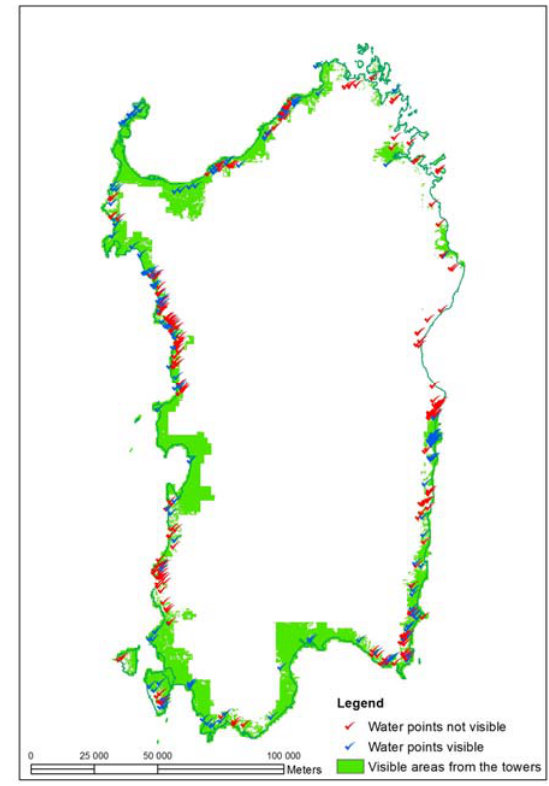
Figure 12: visibility study of the water supply